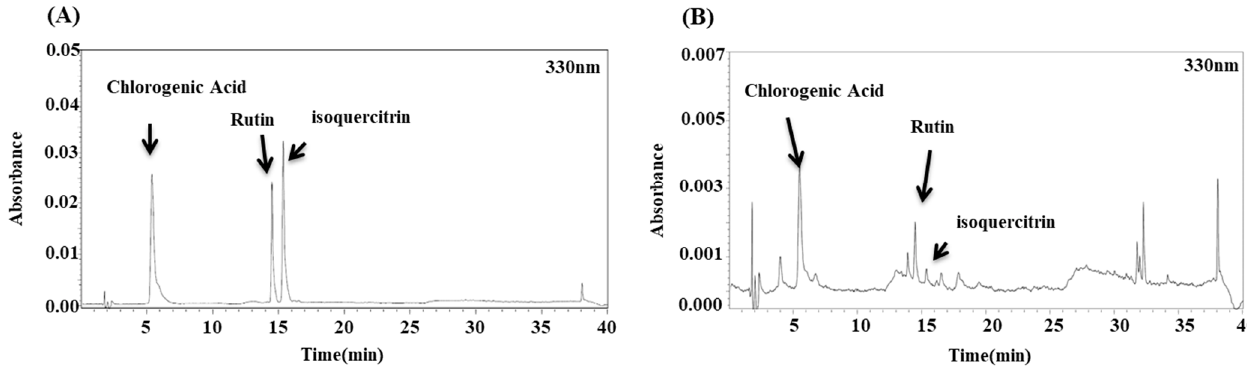
Figure 4. Chromatogram of standard and IW leaf extracts: ( A ) standard, ( B ) ethanol extract .